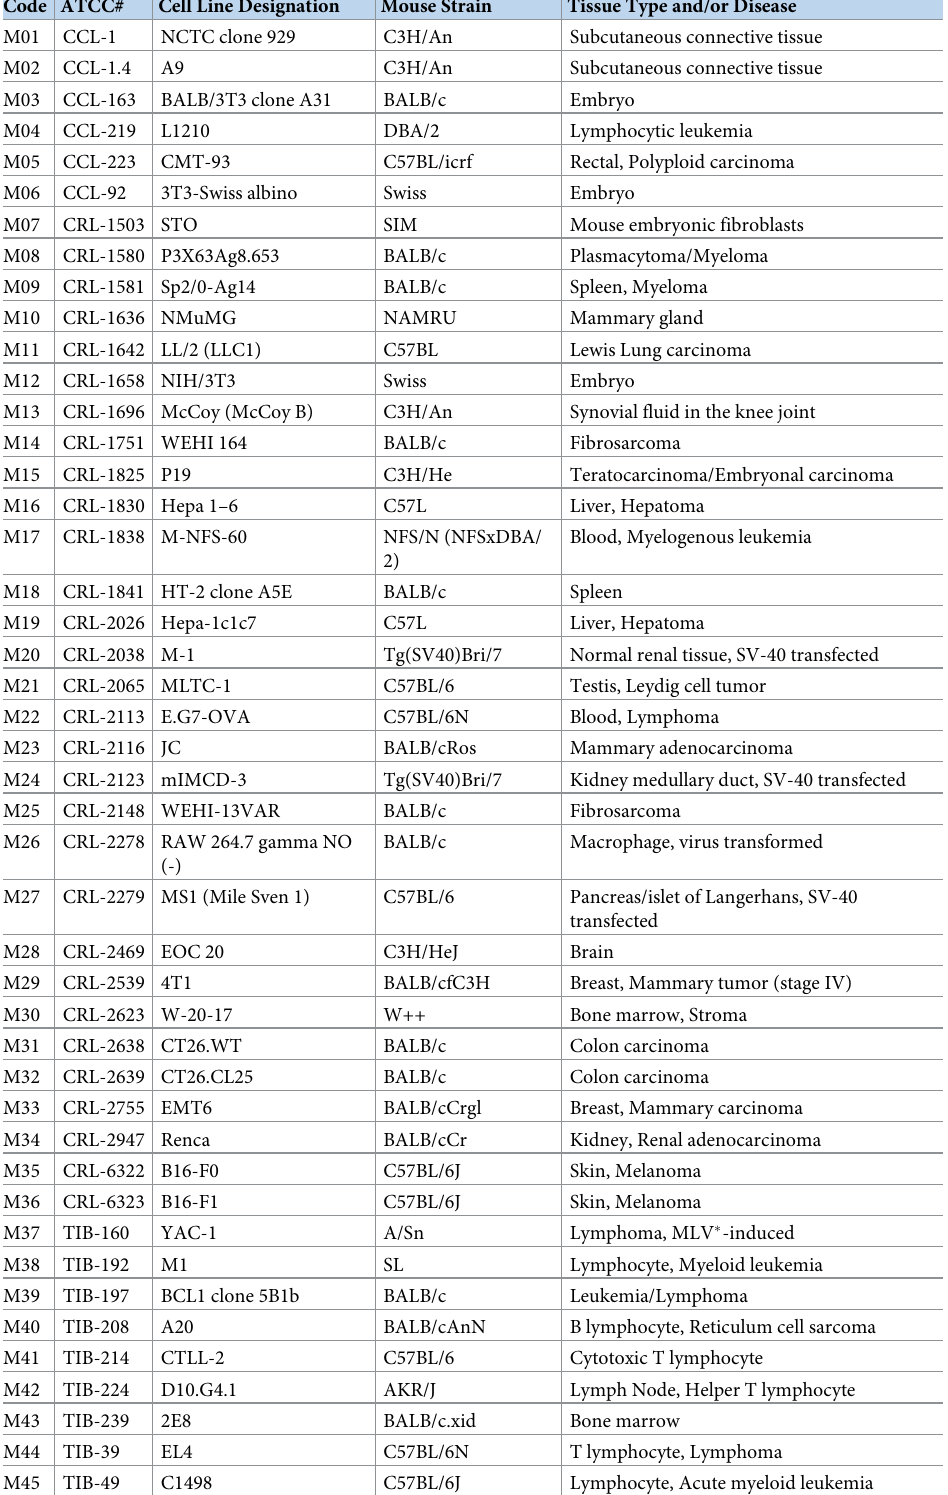
Table 9. Cell lines used in the interlaboratory